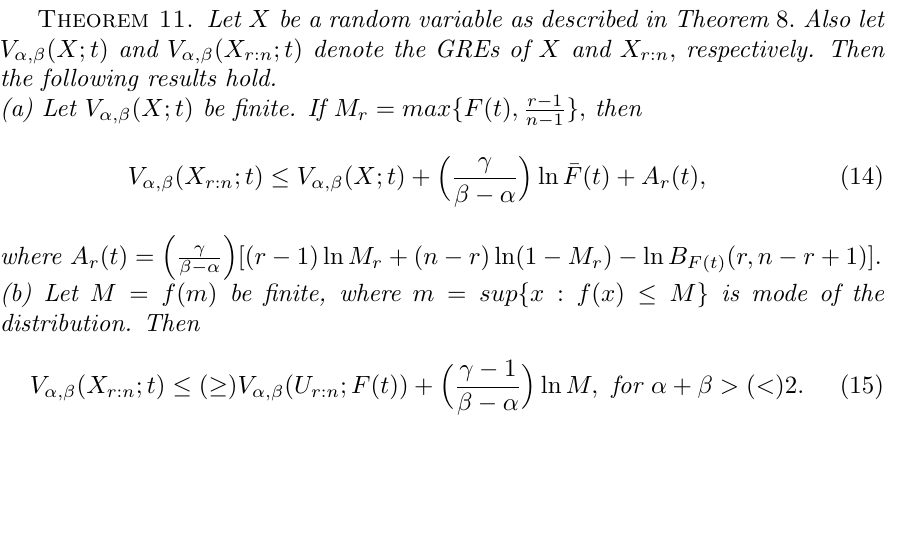
is not monotone in 0 (cid:20) t < 1 ; for the same values of (cid:11); (cid:12) and n = 10 (see Fig. 4( b